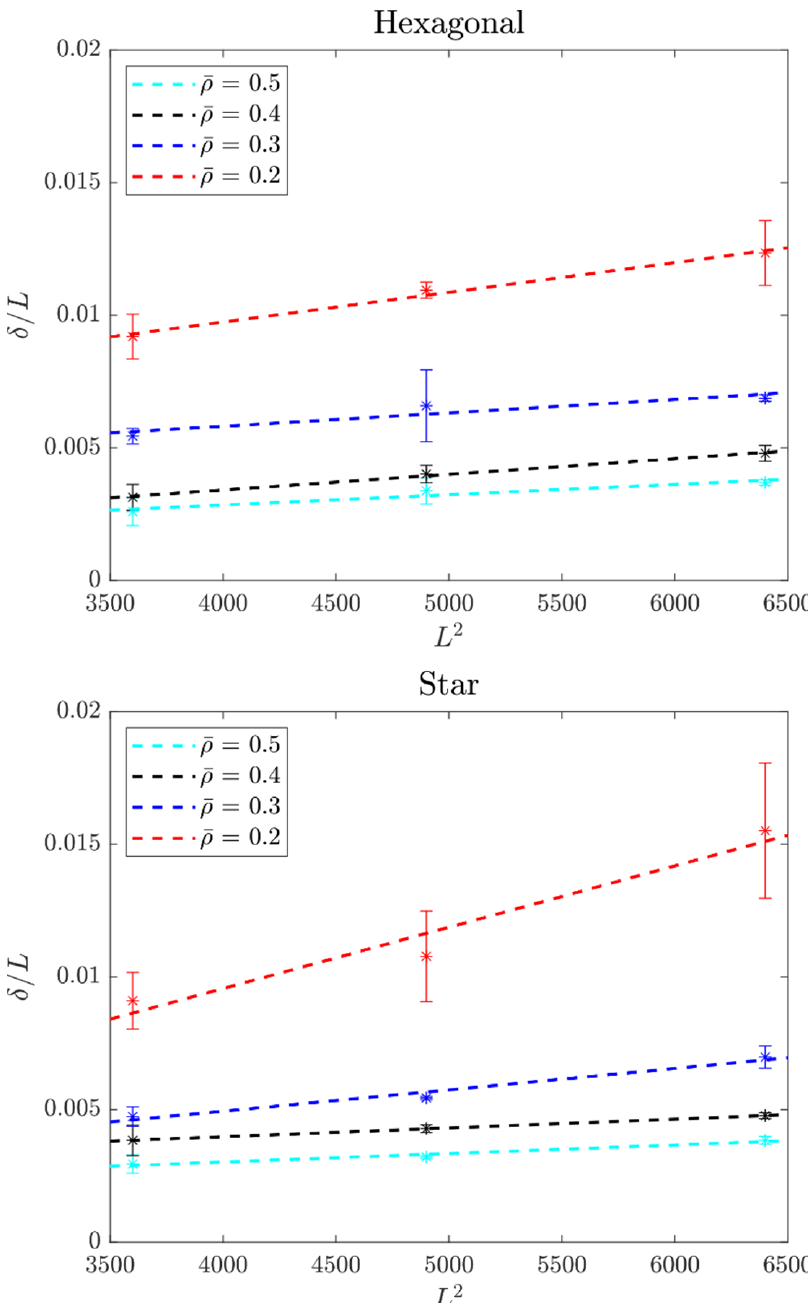
Figure 6. δ /L vs. L 2 for both lattice structures.